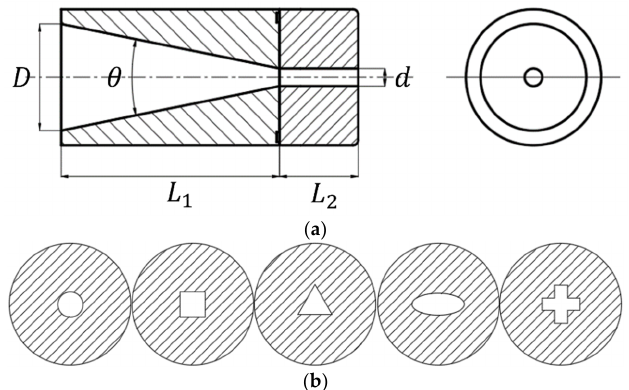
Figure 4. Structural parameters and shape of the nozzle: ( a ) main structural parameters of the nozzle; ( b )outlet section shape. Table 2. Structuralparameters of the nozzle.